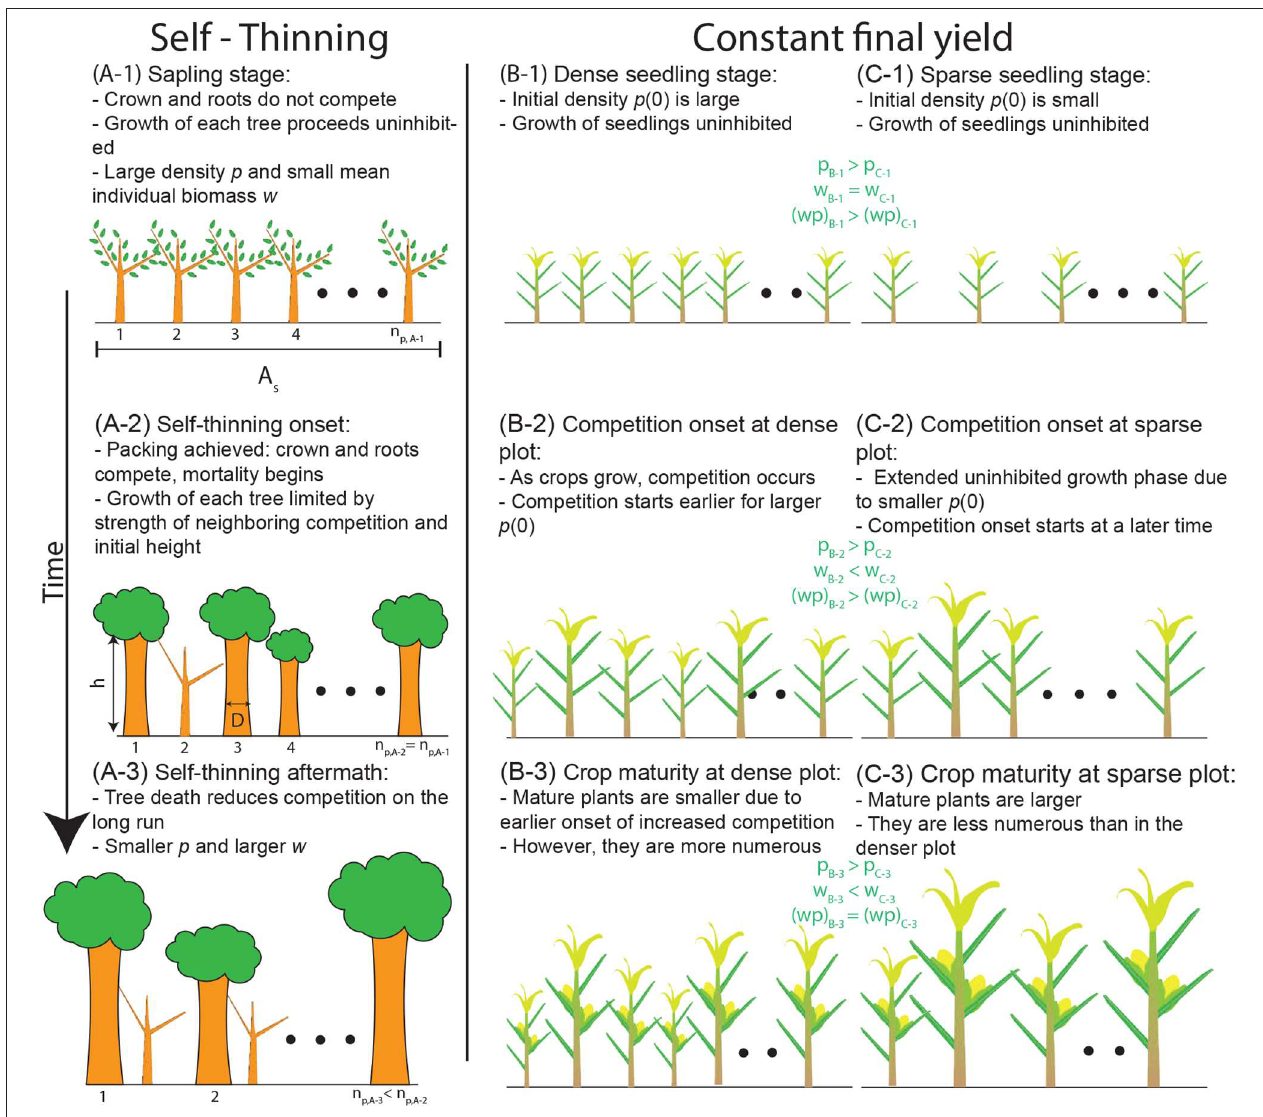
FIGURE 1 | Conceptual representations of (A) self-thinning and (B,C) the constant final yield rule. (A) Self-thinning is initiated after crowding occurs, resulting in decreasing plant density p ( t ) with time t . (B) A high initial planting density p 0 is compensated for by poor growth conditions for each individual resulting in a small individual biomass w at harvest after an initial growth time period (B-3) . (C) Conversely, a small p 0 allows for improved growth conditions leading to higher w at harvest after the same growth time period (C-3) . The choice of a woody species in column (A) and a herbaceous species in columns (B,C) is to highlight the wide applicability of the self-thinning and constant final yield rules. Symbols: n p refers to the number of plants in a plot, A s is the plot ground area, D is the stem diameter, h n p / A s is the plant density, w is the mean individual biomass, and the product wp is the total biomass per unit ground area at time t . Subscripts is the plant height, p = refer to the different scenarios